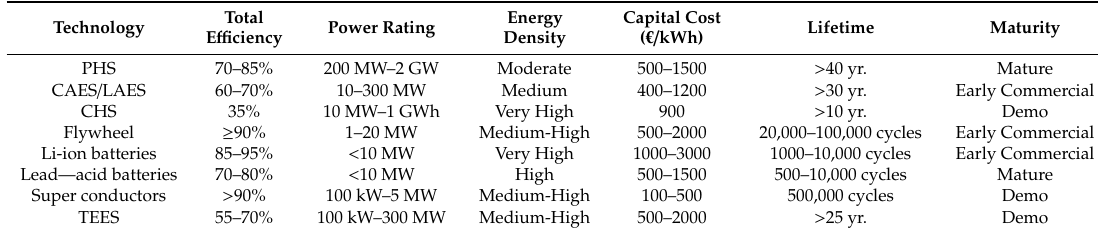
Table 1. Technological characteristics of energy storage systems